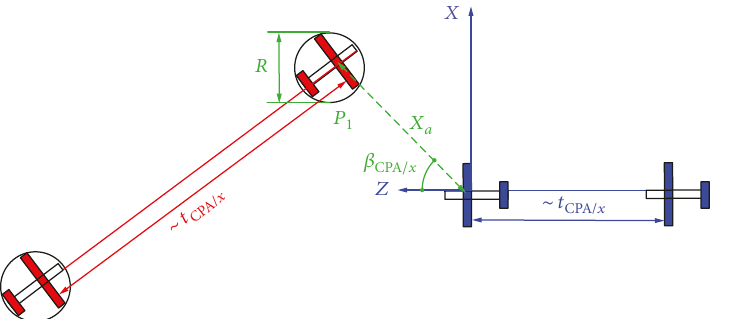
: the horizontal 1